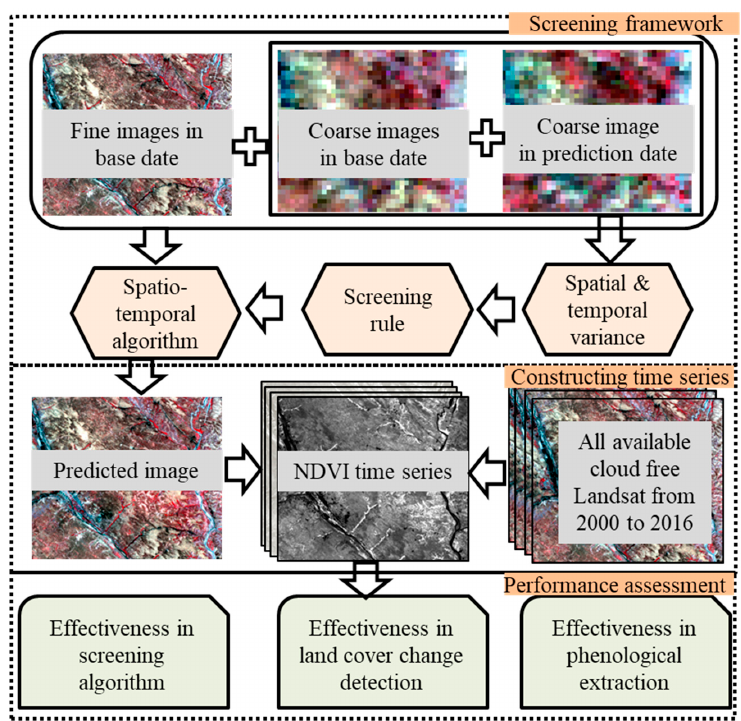
Figure 1. Framework for Landsat normalized difference vegetation index (NDVI) time series construction using the spatiotemporal fusion algorithm screening scheme.